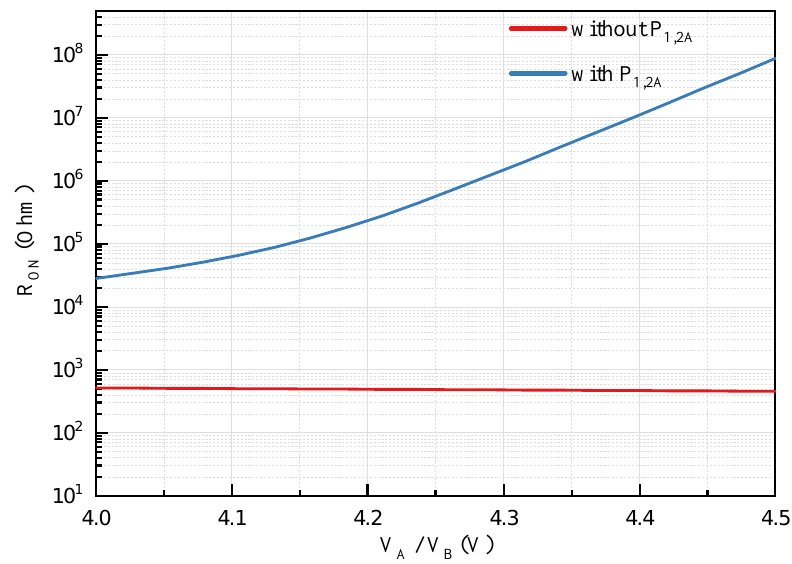
Figure 7. On-resistance of P 1 (P 2 ) with and without P 1A (P 2A ).